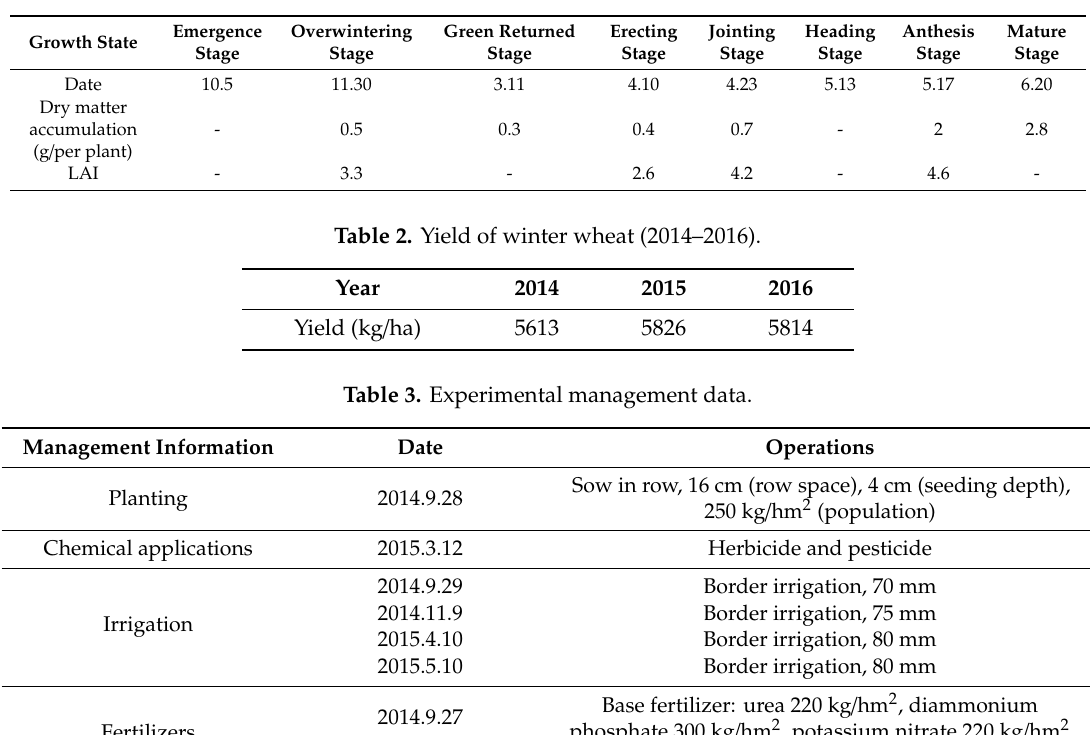
Table 1. Information on winter wheat phenology during 2014–2015.